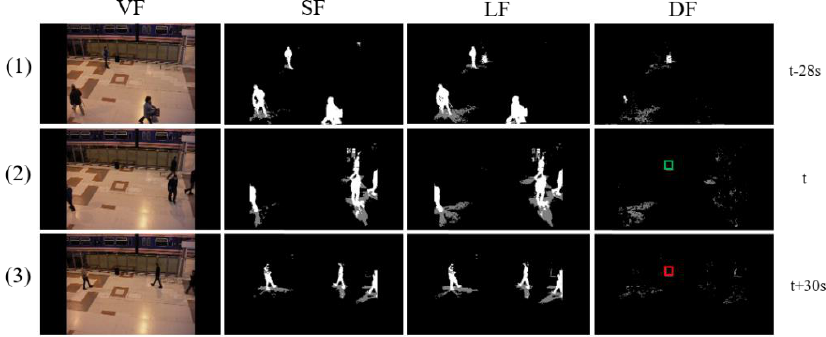
Figure 2. Abandoned object detection in PETS2006 Scenario 7. (VF, SF, LF, and DF represent video frame, shot-term foreground, long-term foreground, and difference foreground, respectively).